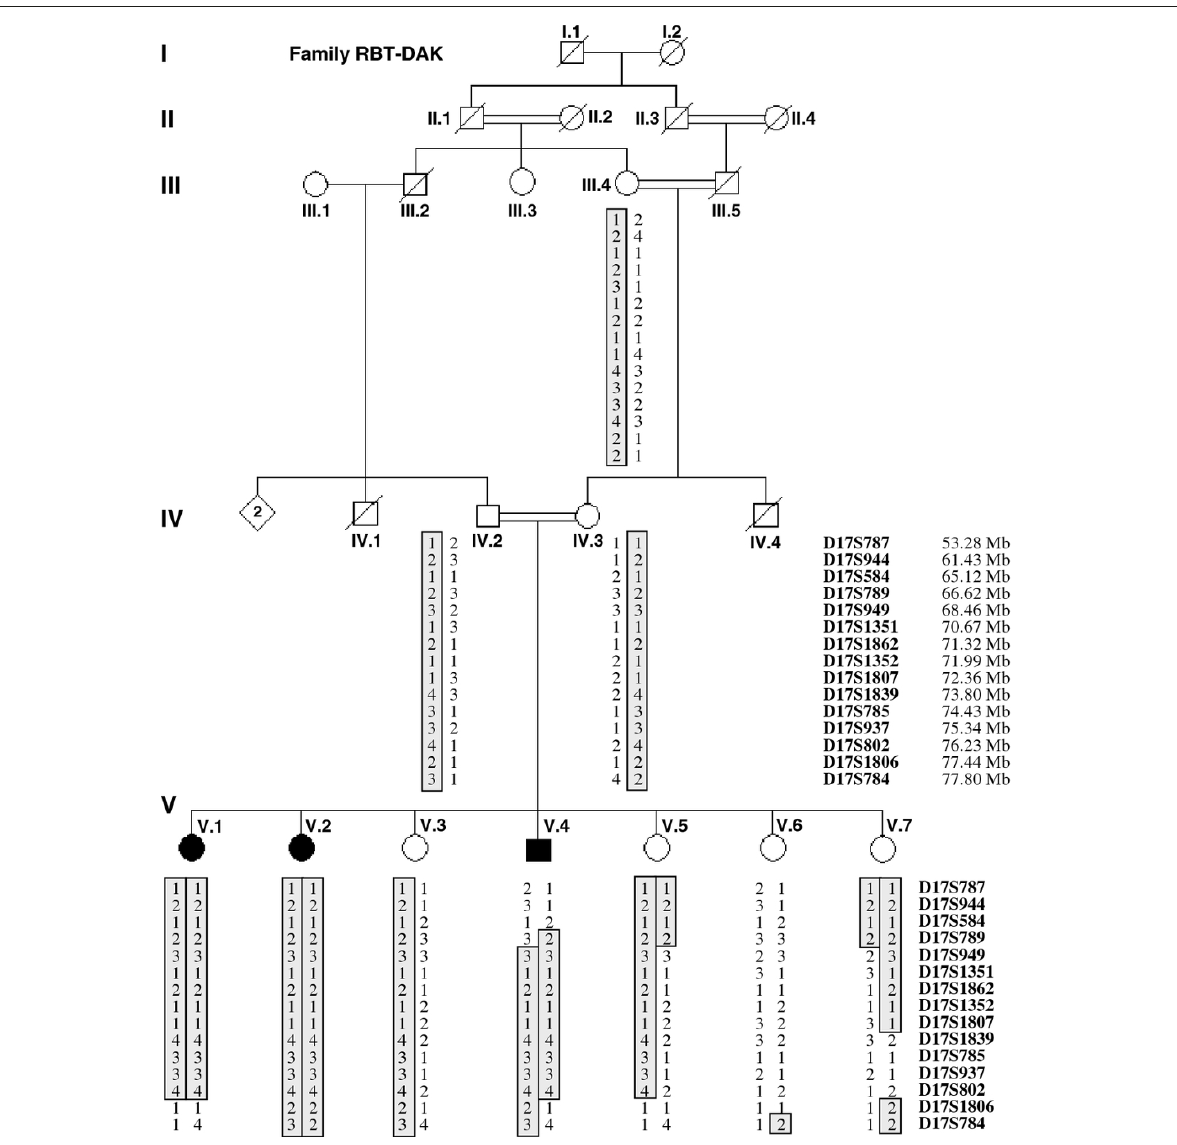
Figure 1 Haplotype reconstruction for chromosome 17q in pedigree RBT-DAK . Microsatellite markers are ordered according to the ensembl genetic map from centromere (top) to telomere (bottom). The hatched area represents the homozygosity region for each